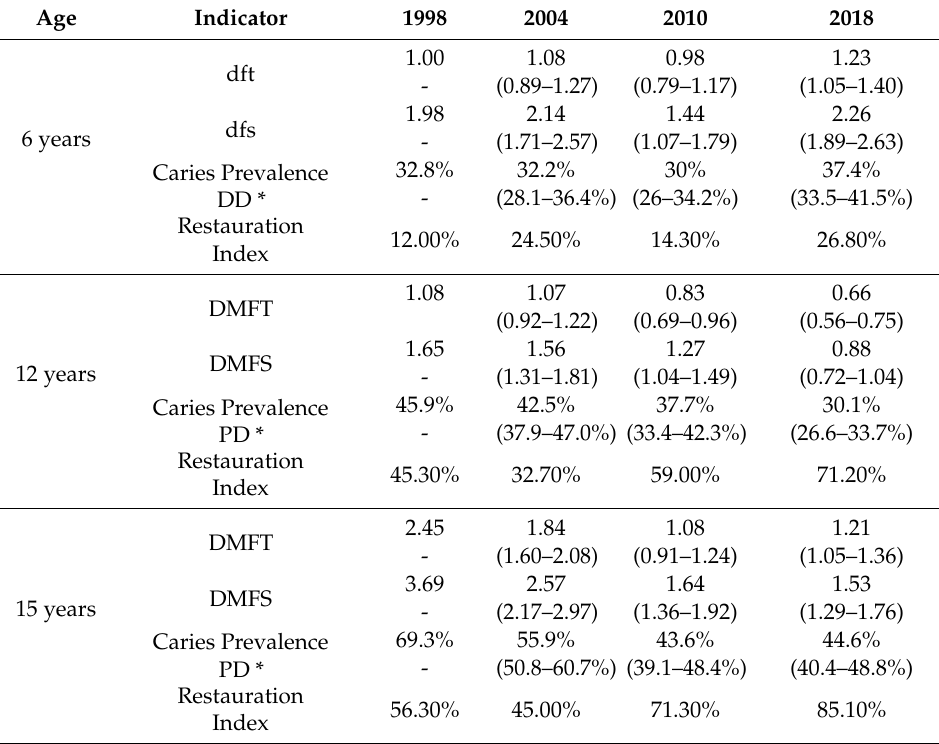
Table 5. Evolution of the main indicators of dental caries between 1998 and